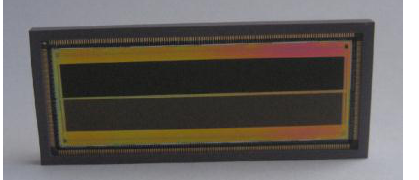
Figure 4 MEDUSA CMOS sensor chip with 2 sensors on a